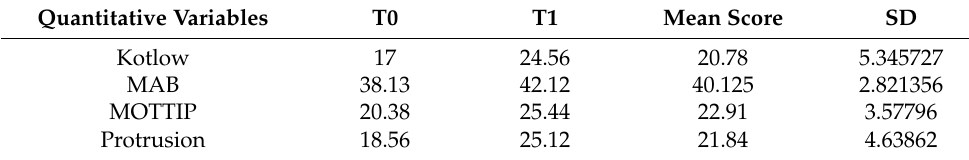
Table 8. Comparison of T0 and T1 of the SG in relation to the quantitative variables. Quantitative Variables